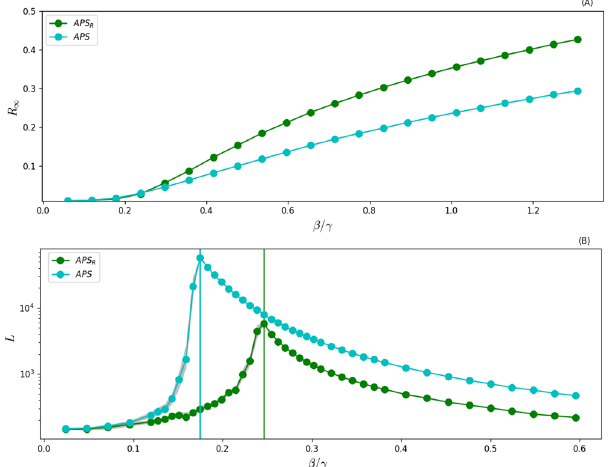
Figure 6. Panel (A) R ∞ as a function of β / γ for SIR processes diffusing on APS (cyan circles) and on the randomized APS dataset (green circles). Panel (B) L as a function of β / γ for a SIS models evolving on the same two networks. Each point is the average of 10 2 independent simulations started from 1% of random seeds. We fix γ =